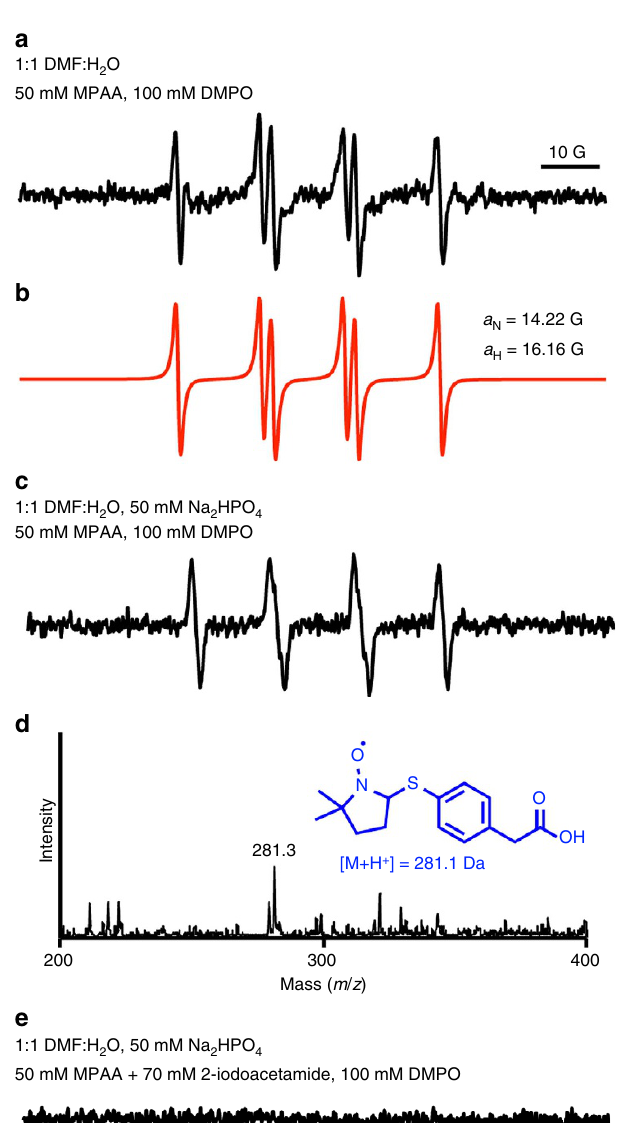
Figure 3 | EPR spectra of DMPO/ (cid:2) S-Ar adduct. ( a ) Spectrum obtained upon incubating 50mM MPAA and 100mM DMPO in a 1:1 water-DMF mixture at 25 (cid:2) C. ( b ) Computer simulation of the spectrum observed in a with hyperfine splitting constants a N ¼ 14.22G and a H ¼ 16.16G 23